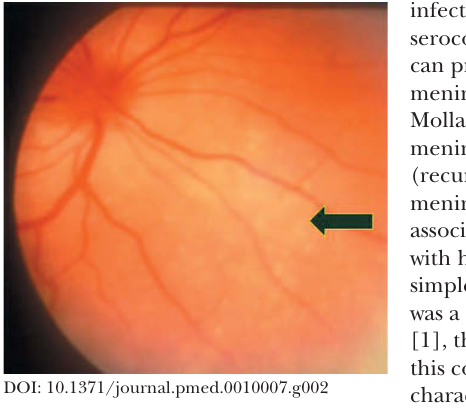
Figure 2. White Choroidal Infi ltrates (Arrow) Seen in VKH Syndrome with Very Pink Optic Nerve Head